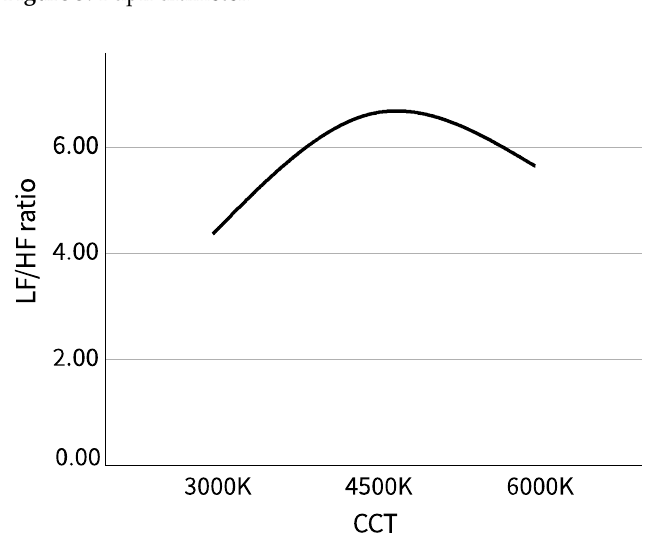
Figure 4. LF/HF Figure 4. LF/HF ratio.